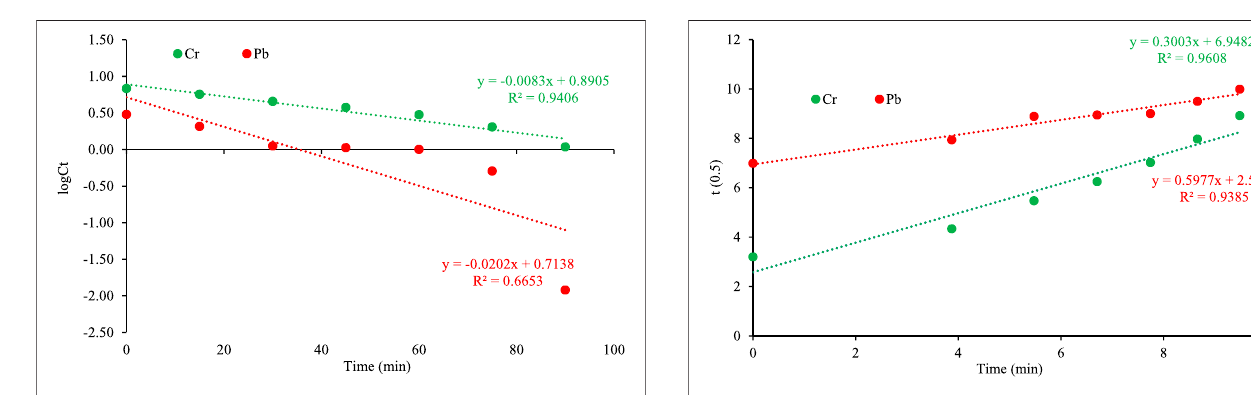
FIGURE 9 | First order kinetic plot of adsorption on orange peel/ selenium nanocomposite. The pseudo-second order is represented by the following equation (Asfaram et al., 2015; Li et al., 2015).